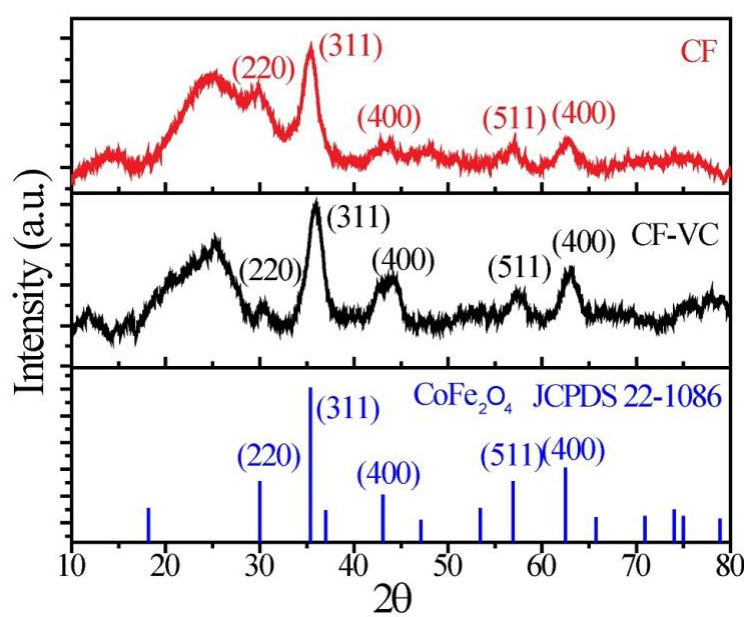
Figure 2. Powder diffraction patterns for cobalt ferrite (CF) nanoparticles, the CF-VC composite catalyst and CoFe 2 O 4 (JCPDS 22-1086).